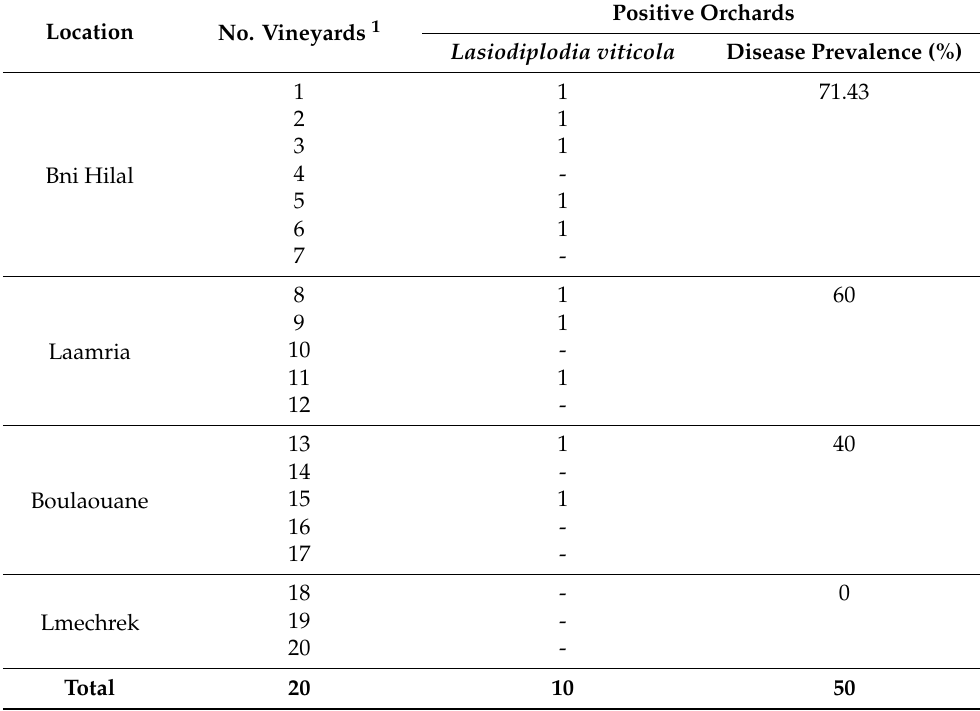
Table 1. Occurrence and distribution of pathogenic fungus in vineyards in Doukkala-Abda region. Location